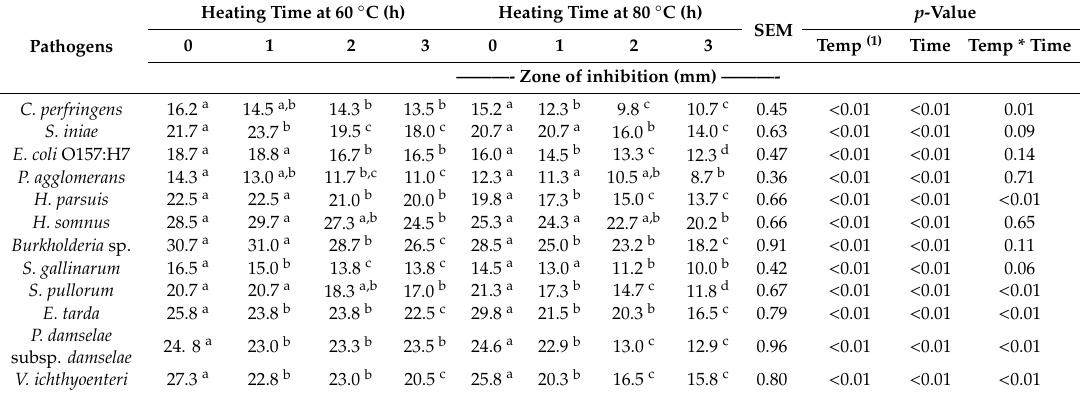
Table 2. Variations in the antibacterial activity of the fresh and heated CC juice subjected to heat